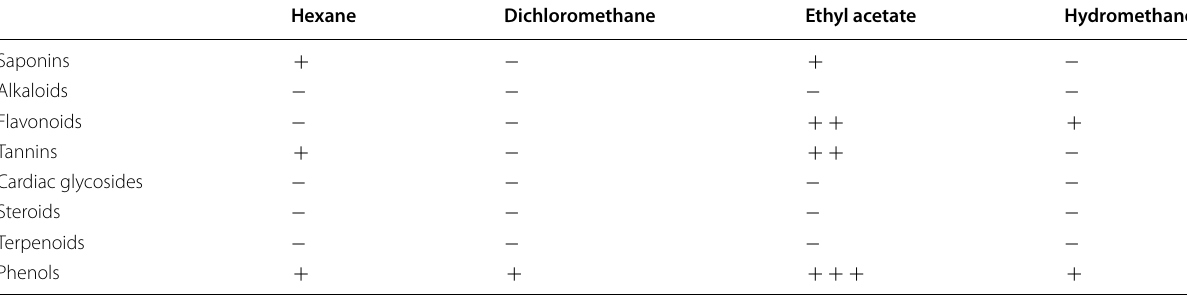
absent, trace amounts, − = + =